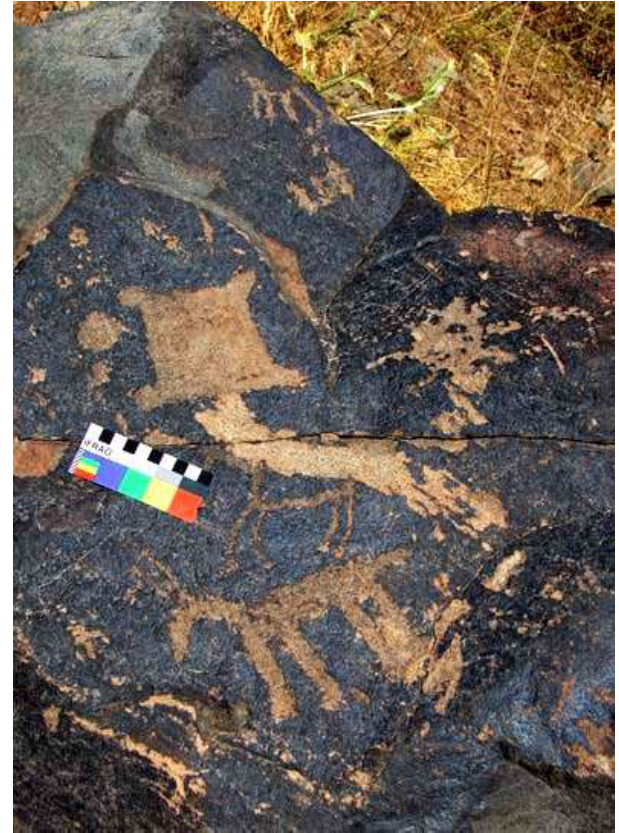
Figure 9. Saral, Kouchekcharmeg village, Sha Jou Mountain, zoomorphs, geometric markings on a single